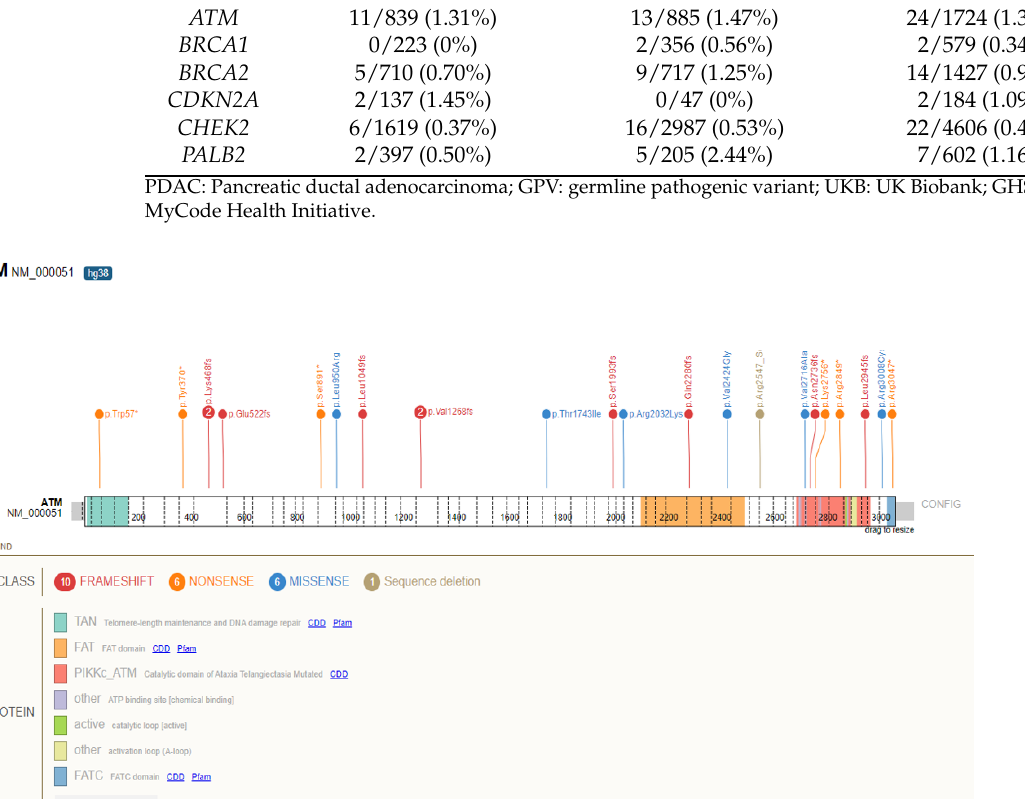
Figure 1. Distribution of germline pathogenic variants in ATM identified in participants with pancreatic ductal adenocarcinoma from the UK Biobank and Geisinger MyCode Health Initiative cohorts. Splice site variant (c.8786 + 1G > A) not shown.